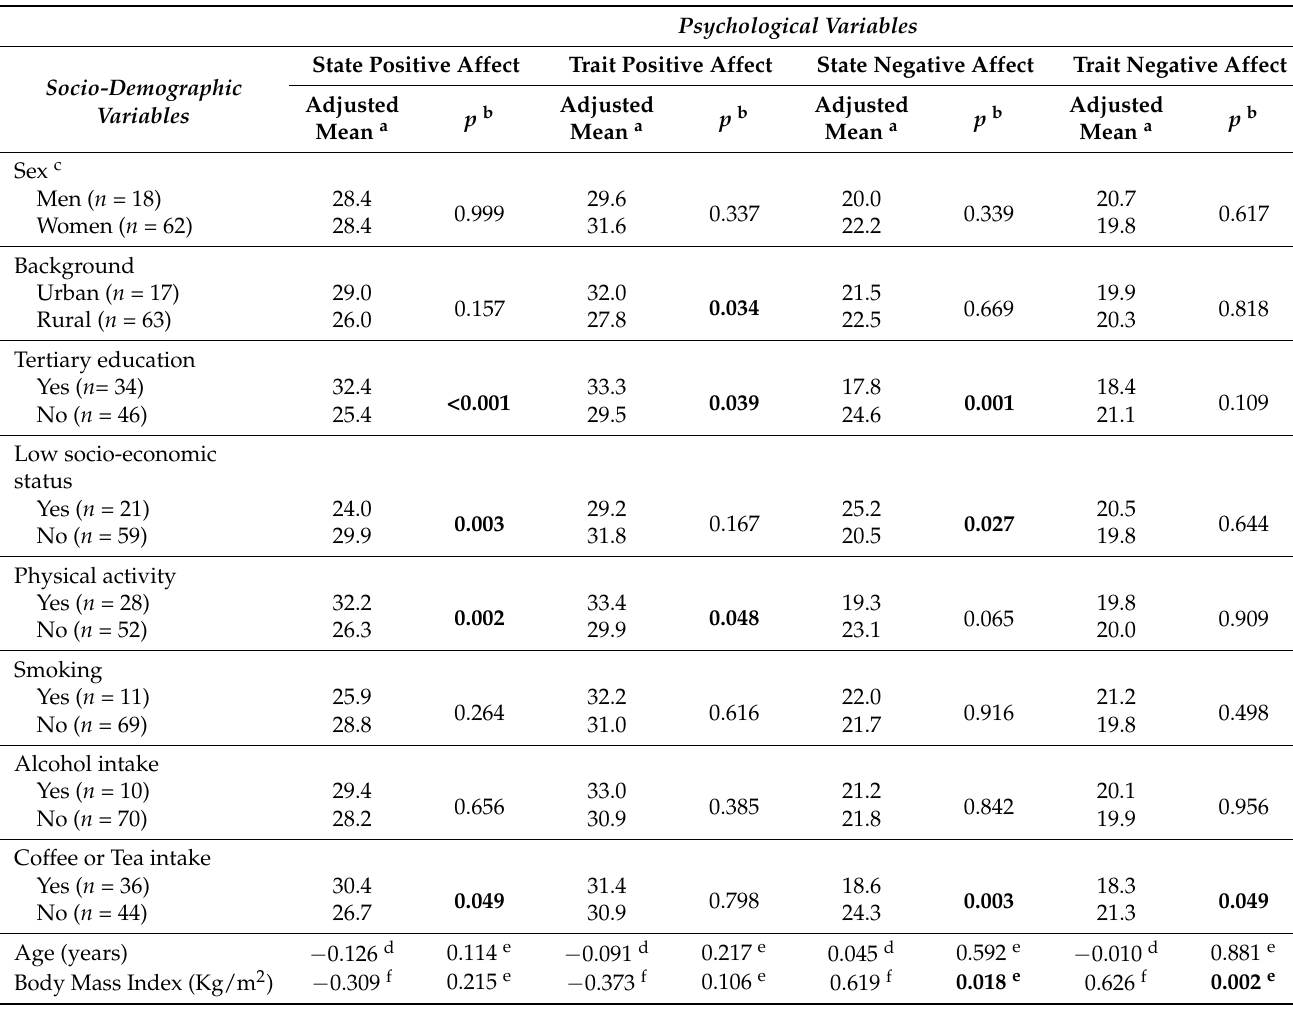
Table 3. Associations of socio-demographic characteristics with scores for State/Trait Positive and Negative